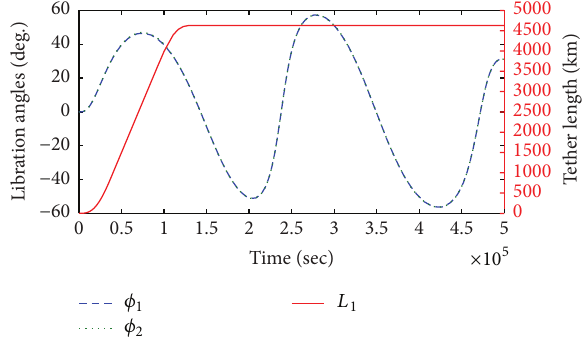
Figure 7: Libration angles and tether length 𝐿 1 by the formulations based on point 𝐶 .